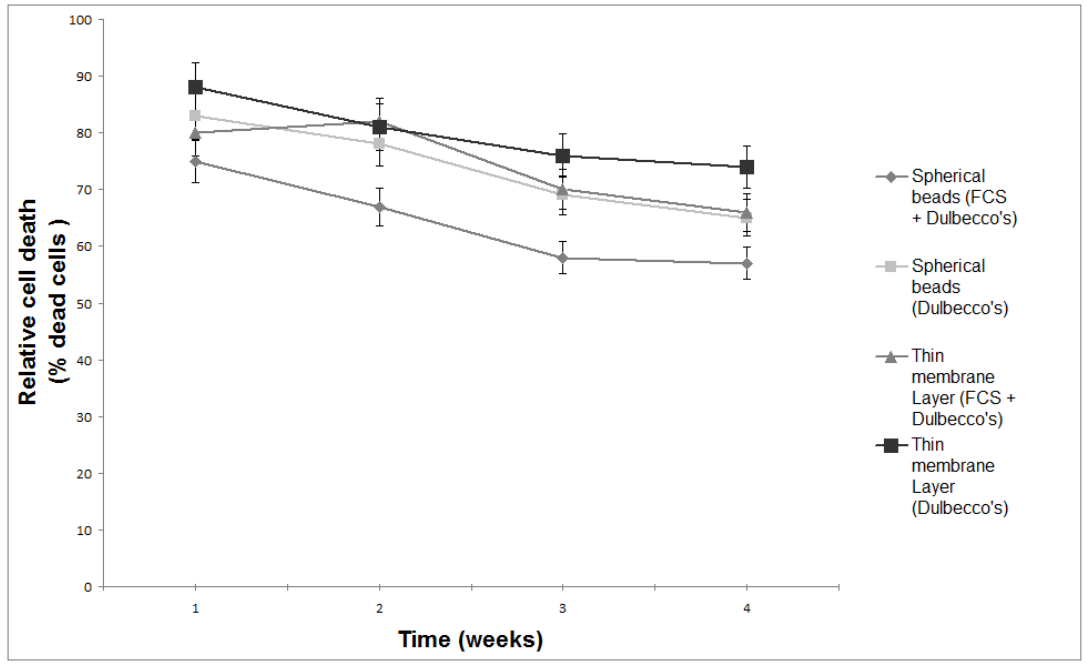
Figure 3. Effect of the shape of the immobilization matrix and the addition of 20% (v/v) FCS on the death of electroporated Vero cells, as indicated by trypan blue staining (electroinsertion of SOD. Percentage of dead cells which absorb the stain/cell density. n =10 replications and error bars represent standard errors of the weekly average value of all